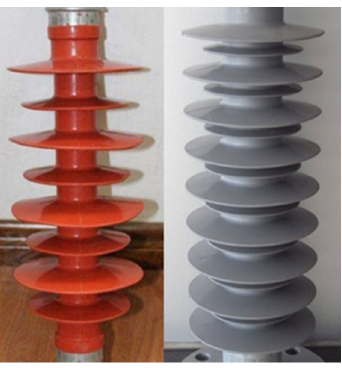
Figure 1. Silicone rubber based composite insulators .